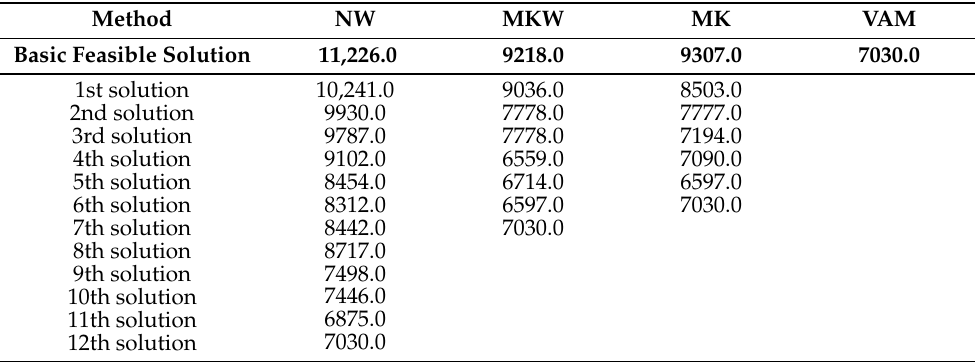
Table 15. Distance traveled (km) depending on solution obtained.